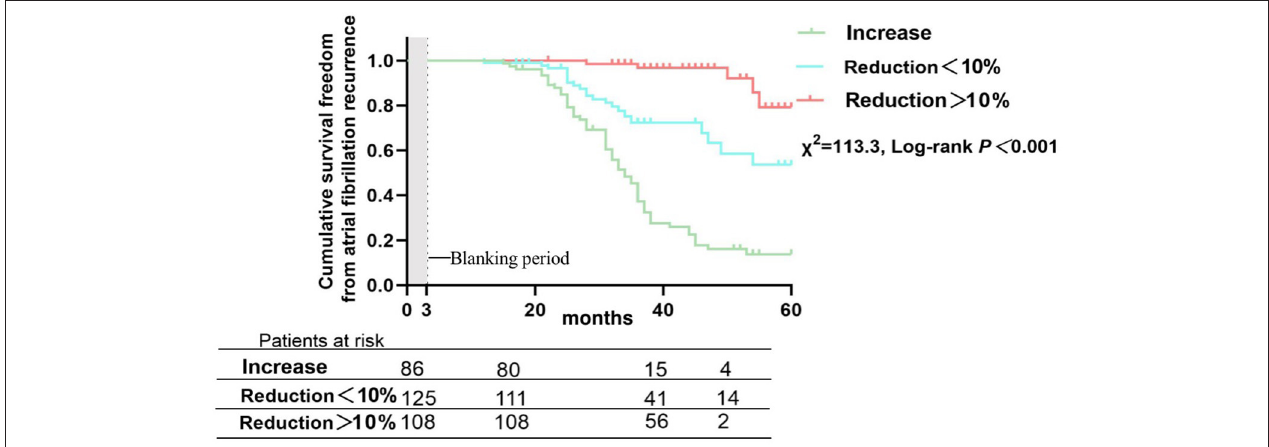
FIGURE 4 | Atrial fibrillation recurrence rates after Cox-Maze IV ablation in patients divided by percentage change in glycated hemoglobin during the 12 months preoperatively.